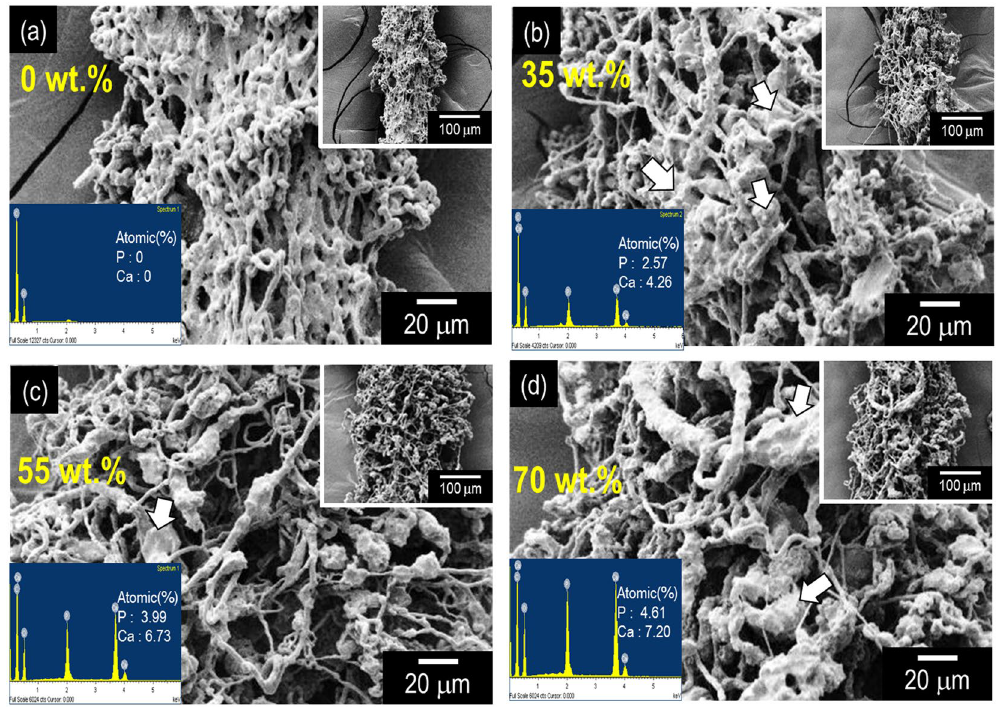
Figure 6. SEM images describing the ability of strut formation and EDS results for various weight fractions of the ceramic (( a ) 0 wt.%, ( b ) 35 wt.%, ( c ) 55 wt.%, and ( d ) 70 wt.%) under selected EHDP process